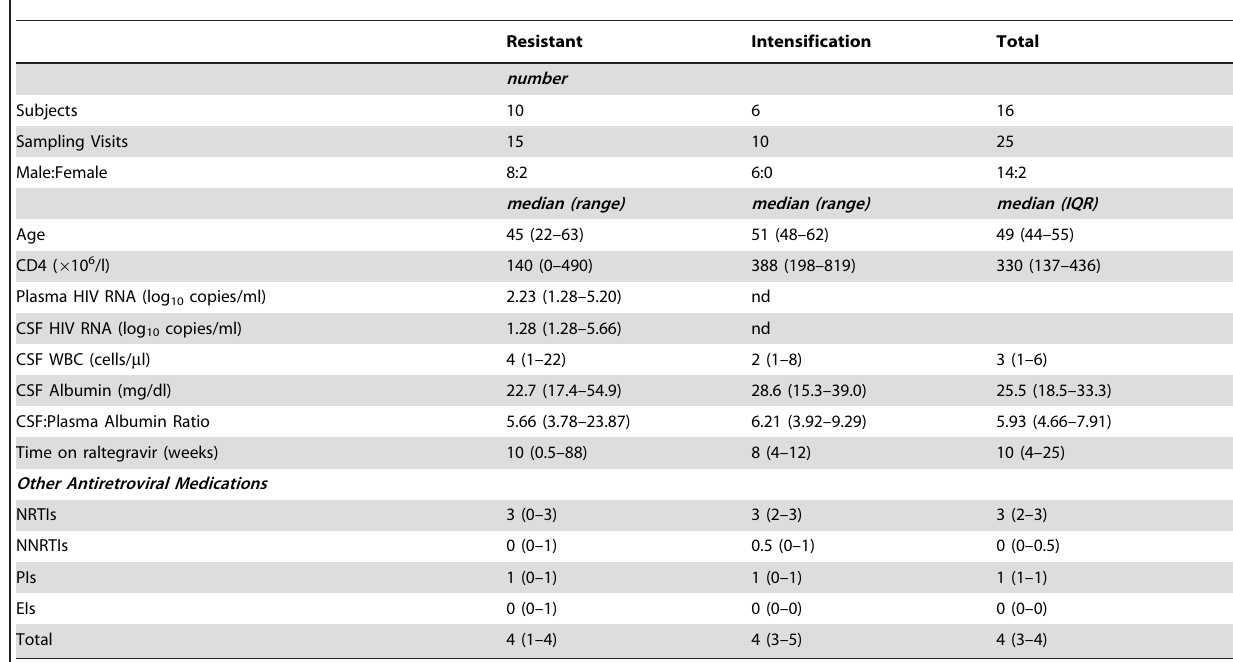
Table 1. Subject